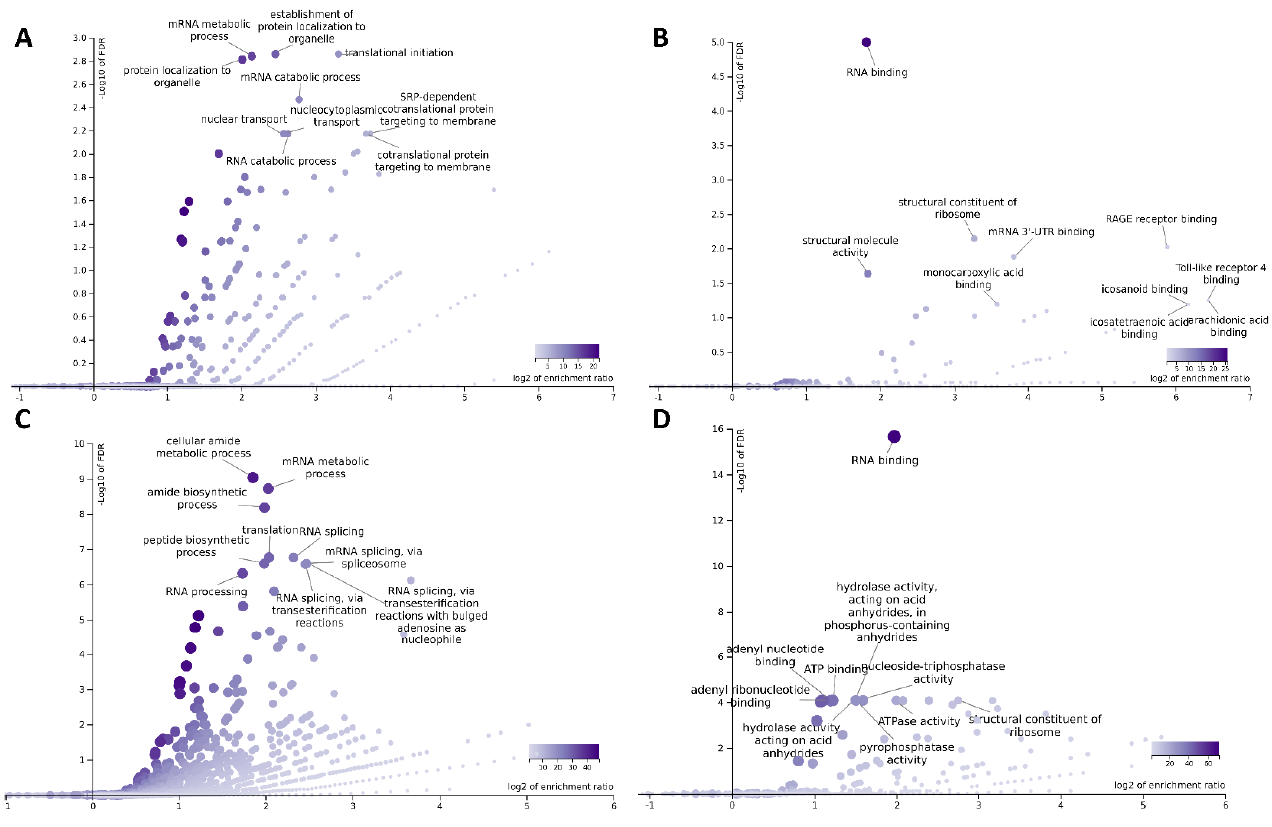
Figure 3. Gene Ontology Biological Process (left) and Molecular Function (right) categories enriched by TIA1 interacting proteins in unstressed ( A , B ) and sodium arsenite-treated ( C , D ) cells. Volcano plots were visualized by WebGestalt analysis software.